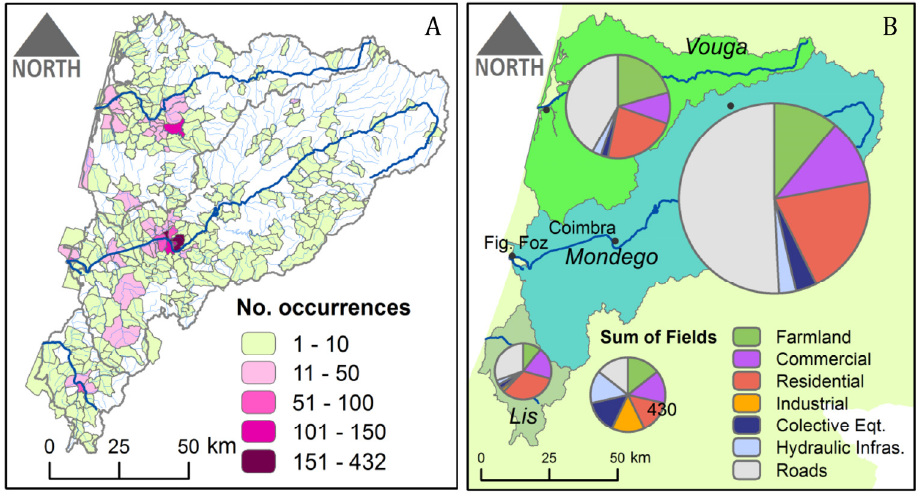
Figure 7. Occurrences with material consequences by parish ( A ) and type of material impact by basin ( B